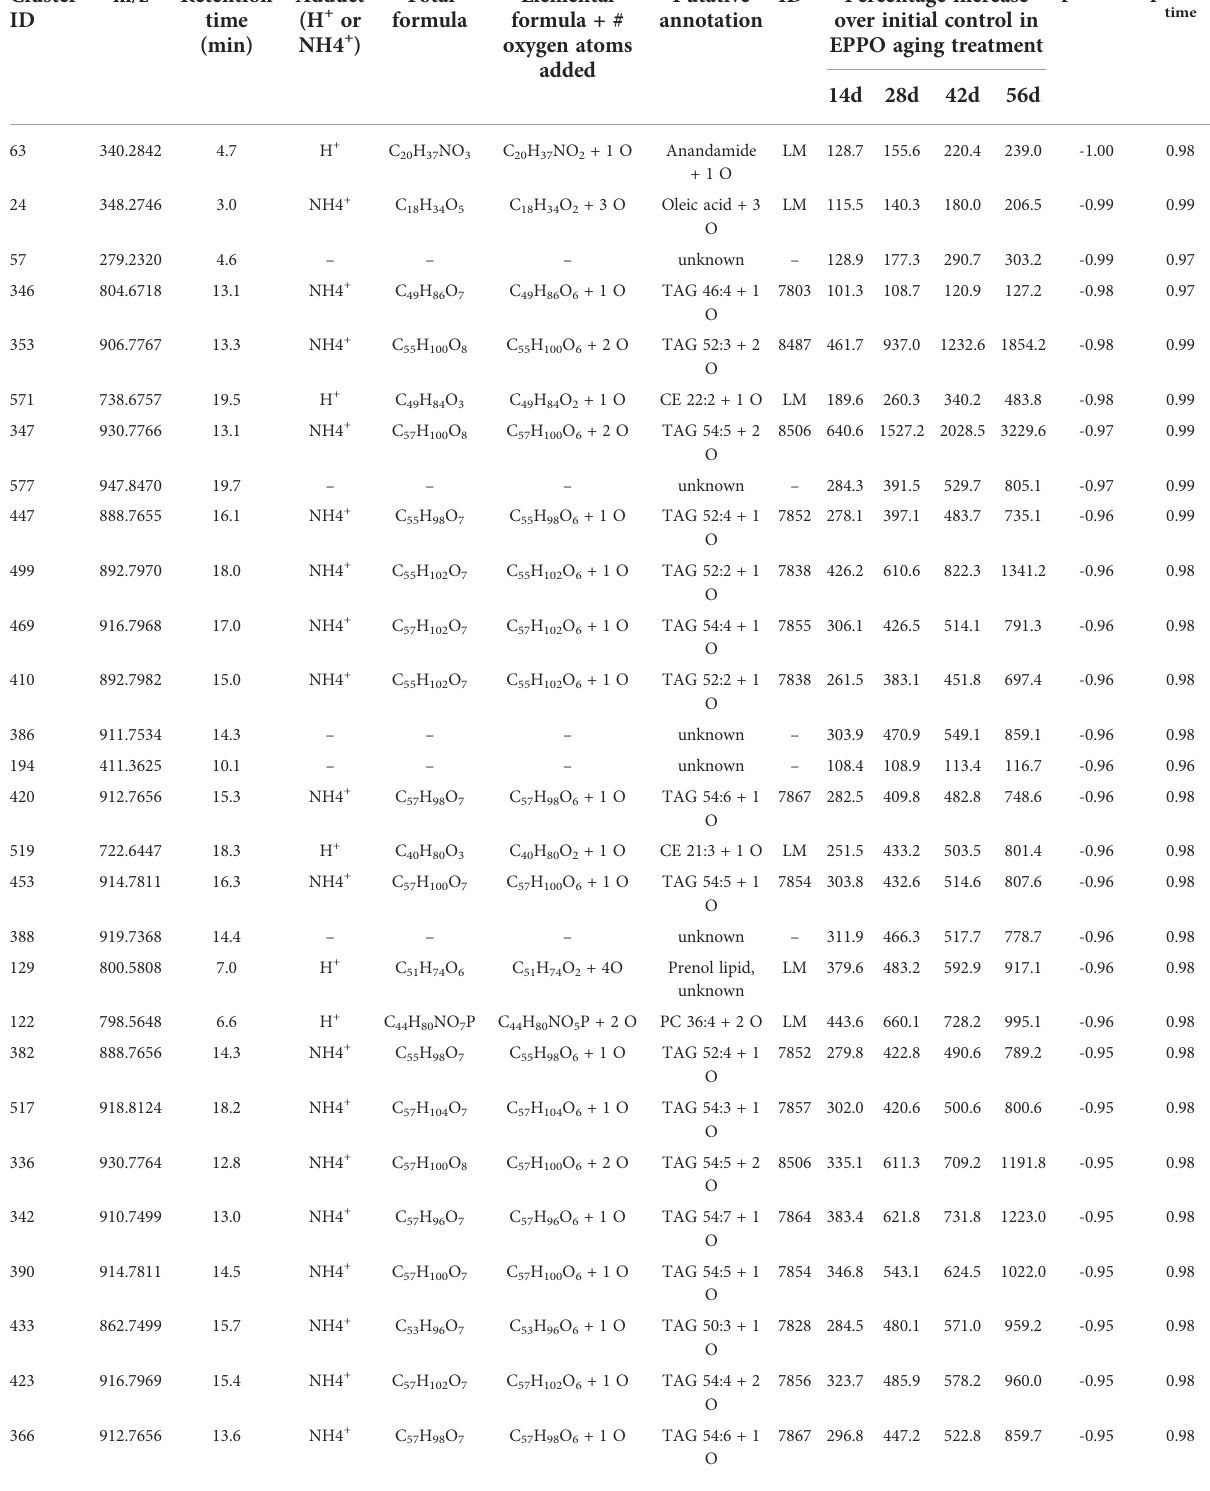
TABLE 2 List of topmost lipids showing the highest correlation with seed viability (%) and storage time (days) in seeds of rice cv. IR64 stored under EPPO aging treatments.